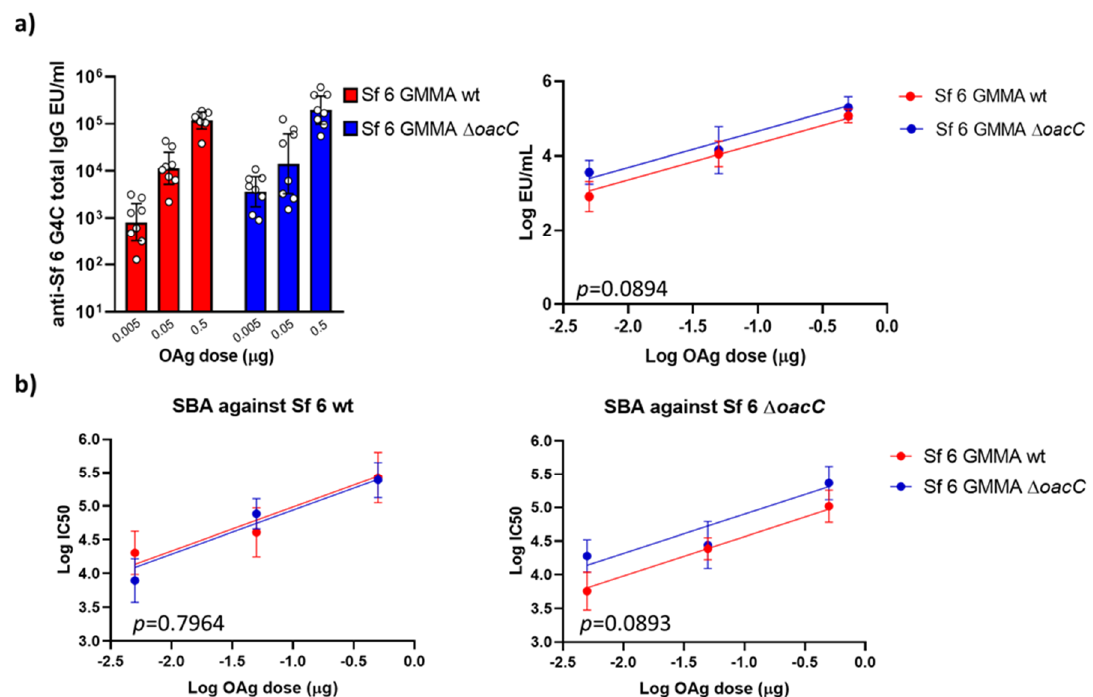
Figure 6. Immunogenicity in mice of S. flexneri 6 (Sf) GMMA differing in O-Ag O-acetylation on Rha III . Eight CD1 mice per group were immunized intraperitoneally with three doses of O-Ag (0.005, 0.05, 0.5 µ g). S. flexneri 6 Group 4 Capsule (G4C), encompassing the same RU of the O-Ag, was used as the ELISA coating antigen. ( a ) Summary graph of anti-G4C specific IgG geometric mean units (bars) and individual antibody levels (dots) on the left; statistical comparison of the resulting dose response curves on the right; ( b ) Summary graphs of SBA IC50 titers against S. flexneri 6 wild type (on the left) and Δ oacC (on the right) strains. ELISA and SBA data were analyzed using the parallel line approach. Each curve represents log-transformed doses on the abscissa and the log-transformed ELISA units or SBA titers on the ordinate. The parallelism of the lines was tested by comparison of the slopes, which resulted in no significant differences. Subsequently, the Y-intercept of the curves were compared, and the p-values are reported in the graphs.